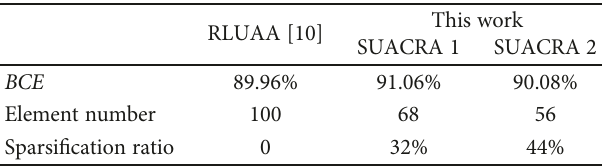
Table 1: Performance comparison of the SUACRA 1, 2, and the